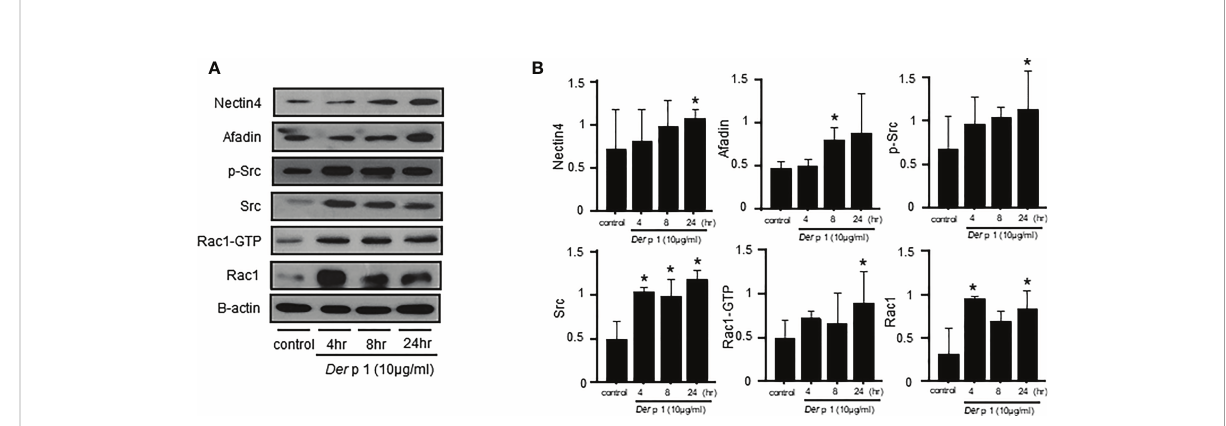
FIGURE 3 Time courses of Dermatophagoides pteronyssinus 1 ( Der p1) allergen-induced Nectin4/Afadin and Src/Rac1 pathway expression. (A) Nectin4/ Afadin and Src/Rac1 pathway expression on western blots. (B) Densitometry of the bands obtained on three western blots. The values were normalized to those of b -actin and are expressed as the mean ± SEM. The results are representative of at least 3 independent experiments. *p<0.05 compared to the control.